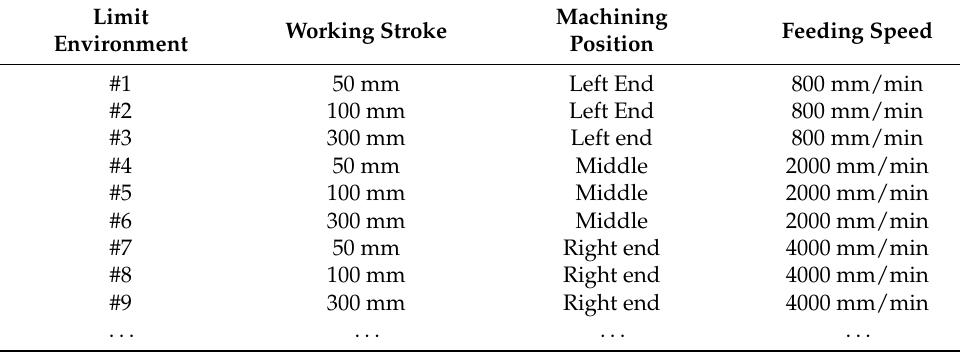
Table 5. Limited motion parameters for the feed